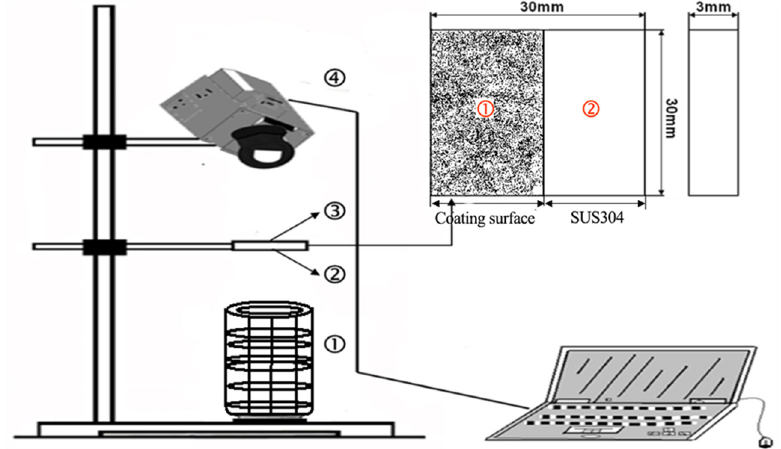
Figure 8. Self-made test device for low temperature insulation performance (heating temperature: 100 °C). ( ① Heating equipment; ② SUS304; ③ Coating surface; ④ Infrared thermal instrument (TVS-700)).